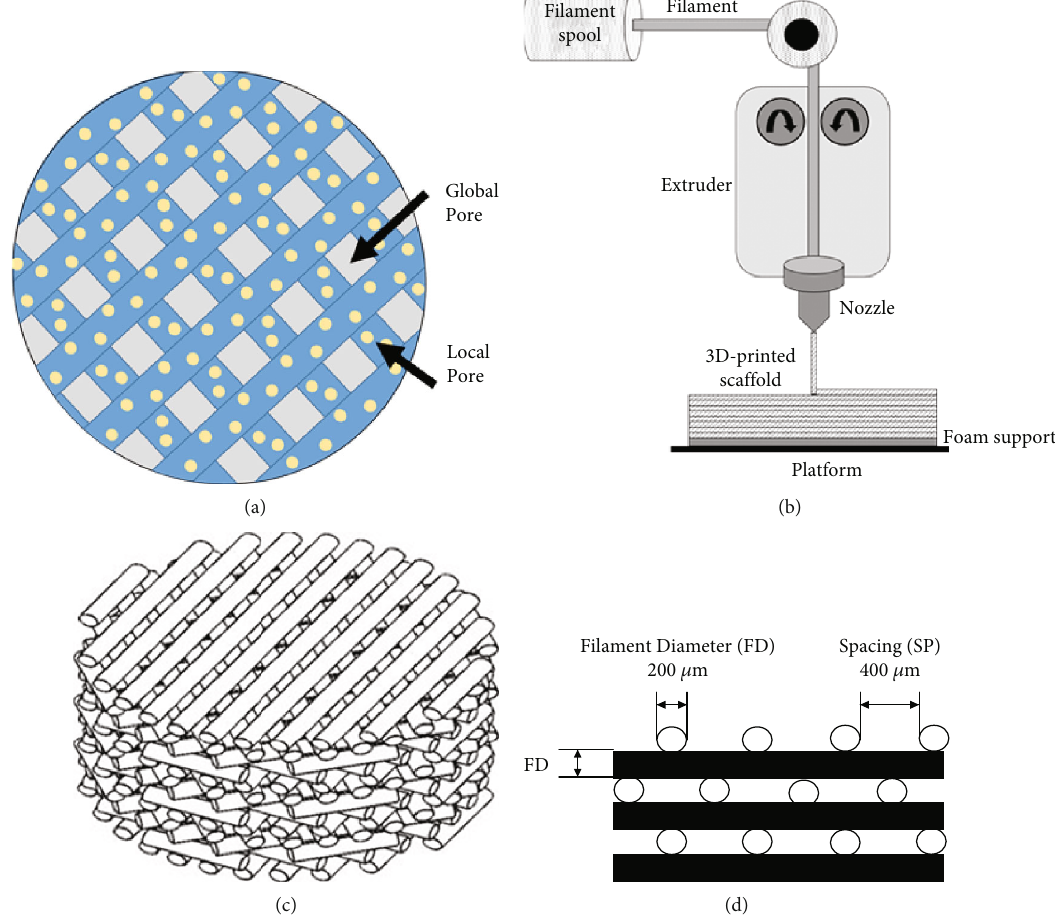
Figure 1: Schematic pictures of (a) global pores and local pores of sca ff old, (b) FDM machine, (c) polymer sca ff old fabricated from FDM, and (d) fi ber diameter and spacing distance of the obtained sca ff